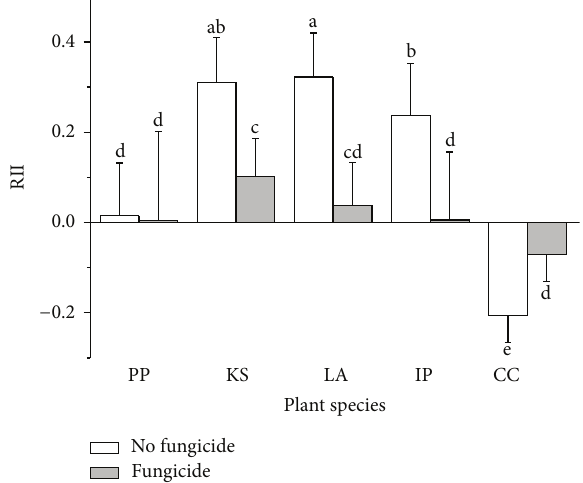
Figure2:Relativeinteractionintensityunderdifferenttreatmentsin the experiment. Data are means ± SD. Different letters represent sig- nificant difference among treatments. PP: Polygonum pubescens ; KS: Kummerowia striata ; LA: Leonurus artemisia ; IP: Ixeris polycephala ; CC: Conyza